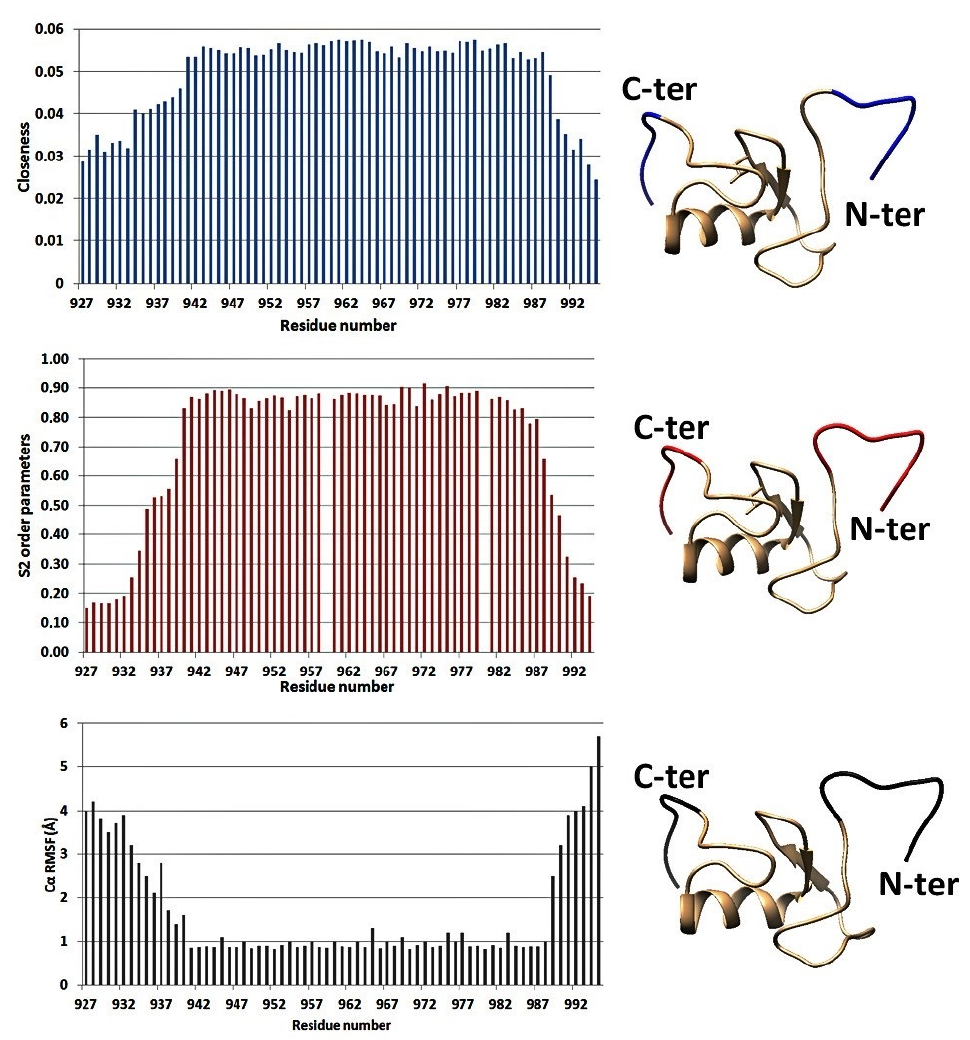
Figure 3. Closeness centrality, S 2 values, and RMSF parameters from MD calculations for the amino acid residues of the RING domain of E3 ligase Arkadia (PDB ID:2KIZ) [48]. The colored regions in the 3D structures in the right panel indicate the flexible segments identified by the corresponding technique.